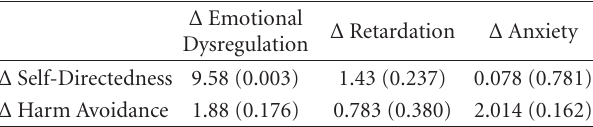
Table 4: The dependence of the change of ( Δ ) Self-Directedness and Δ Harm Avoidance on Δ Emotional Dysregulation, Δ Retarda- tion, and Δ Anxiety in 58 patients assessed over 2 years ( F and P values of a